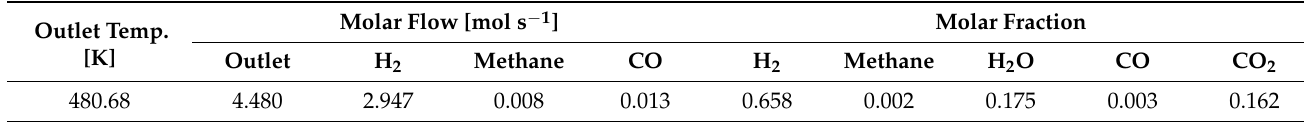
Table 6. Results for (WGS + methanation reactor) outlet